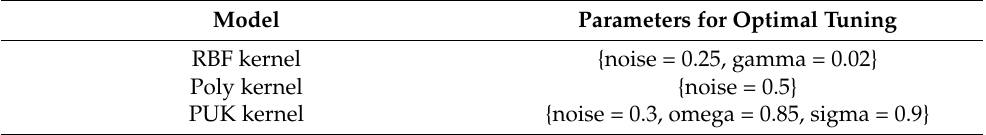
Table 4. Different regression models’ optimal tuning